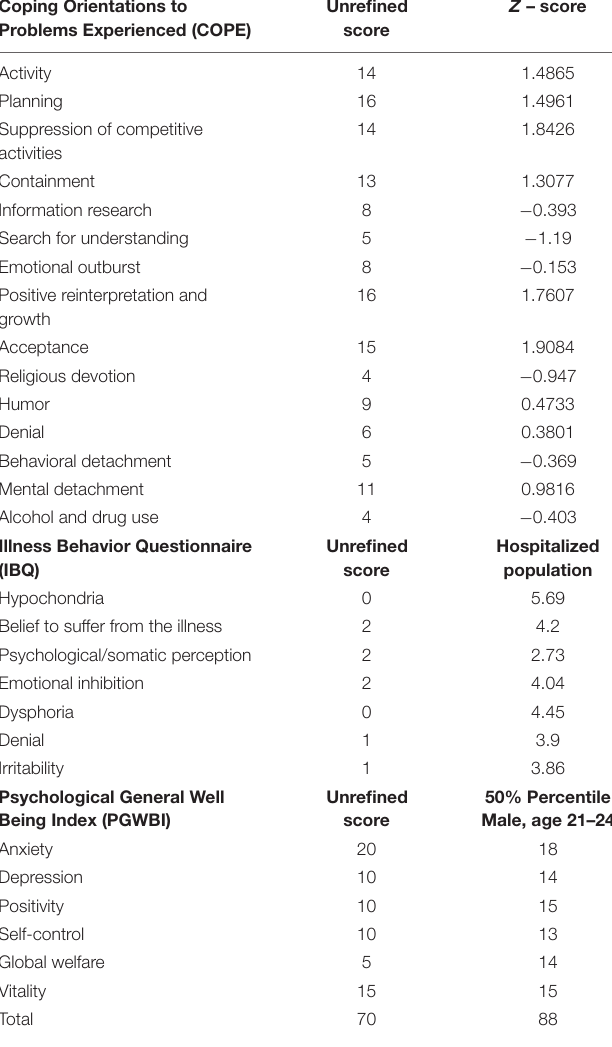
TABLE 1 | Results collected from the patient’s responses to standardized